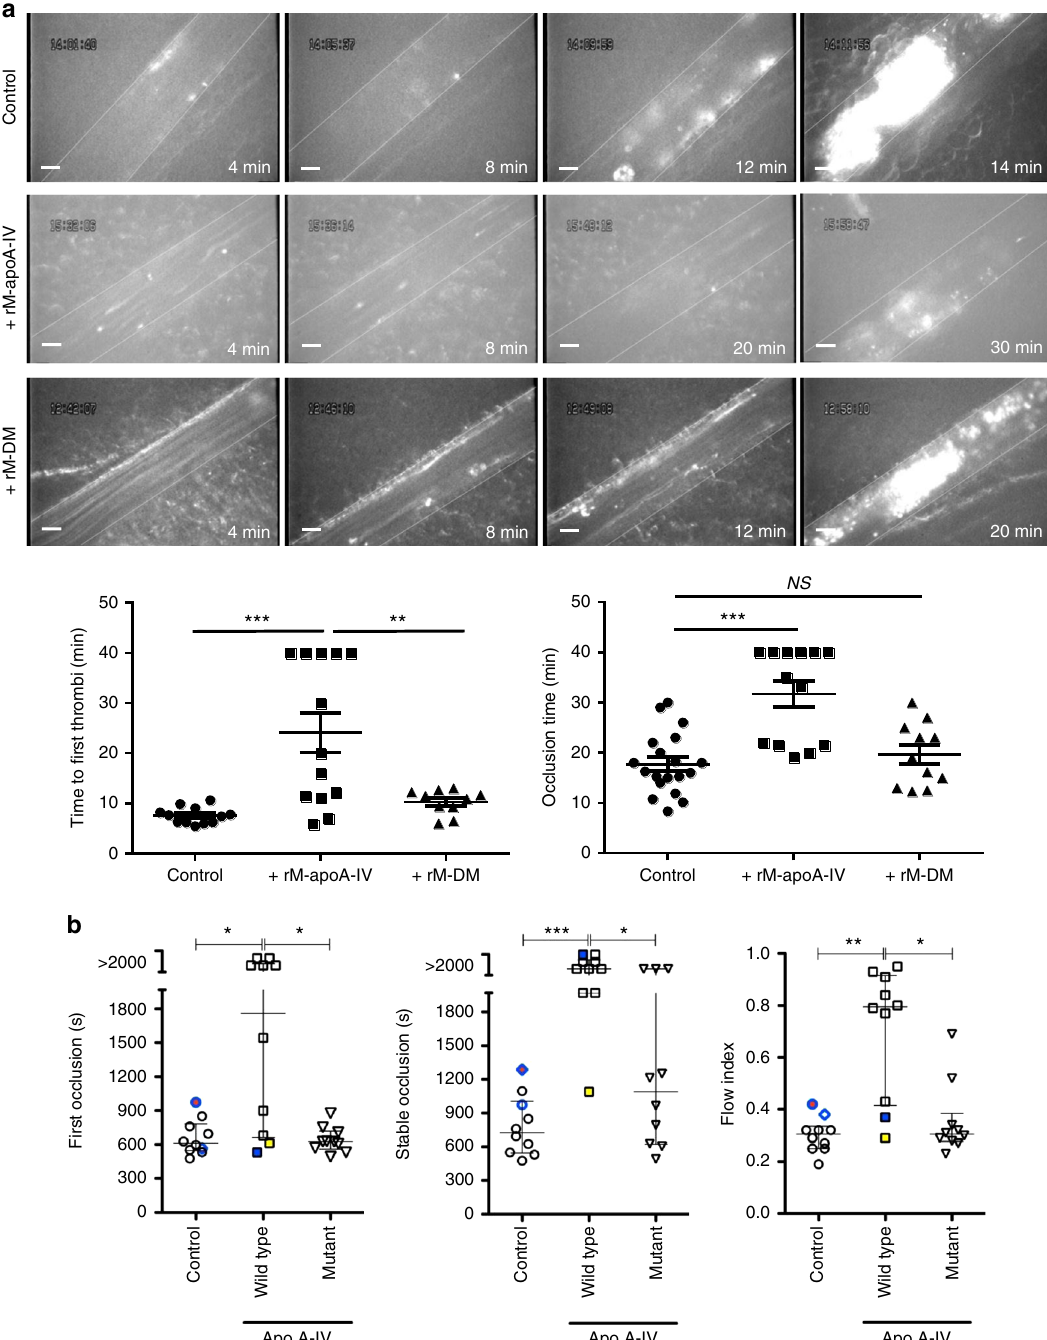
Fig. 8 Intravenous infusion of recombinant apoA-IV inhibits thrombus growth and vessel occlusion in vivo. a Thrombus growth (white) in wild-type mice mesenteric arterioles was inhibited by infusion of recombinant mouse apoA-IV (rM-apoA-IV; n = 13) but not double D mutant apoA-IV (rM-DM; n = 11). Representative images of thrombus growth in all mice tested is shown. b ApoA-IV prevented stable occlusion in a mouse FeCl 3 injury carotid artery thrombosis model. The time to fi rst (left) and stable (middle) occlusion was signi fi cantly prolonged and the fl ow index (right) increased (indicating less decrease in blood fl ow) by infusion of rM-apoA-IV as compared to vehicle (control) or rM-DM ( n = 10). Individual experimental points are shown along with median and interquartile range. In the control group, a circle and diamond with thick blue borders identify two cases that gave a value outside of the 90th percentile (red fi lling) for at least one of the parameters measured; note that abnormalities in the measured parameters are not concordant. In the apoA-IV WT treatment (i.e., rM-apoA-IV) group, a blue and a yellow square identify the two cases in which treatment caused the least change in the blood fl ow index, highlighting that one of them failed to achieve stable occlusion; thus, delayed stable occlusion is the most sensitive parameter to discriminate the antithrombotic effect of rM-apoA-IV infusion. All signi fi cantly different comparisons are shown. apoA-IV WT recombinant mouse apoA-IV, apoA-IV mutant double D mutant apoA-IV. Non-parametric Kruskal – Wallis one-way analysis of variance for multiple paired comparisons. Mean ± SEM. NS not signi fi cant, * P < 0.05, ** P < 0.01 and *** P < 0.001. Scale bars: 10 μ m ( a